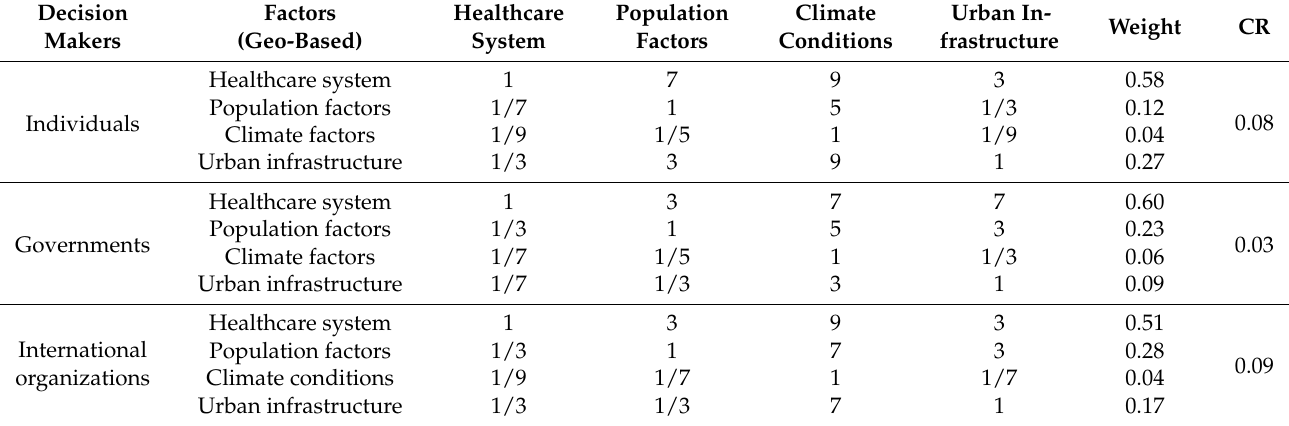
Table 10. Pairwise comparison matrix of factors (geo-based